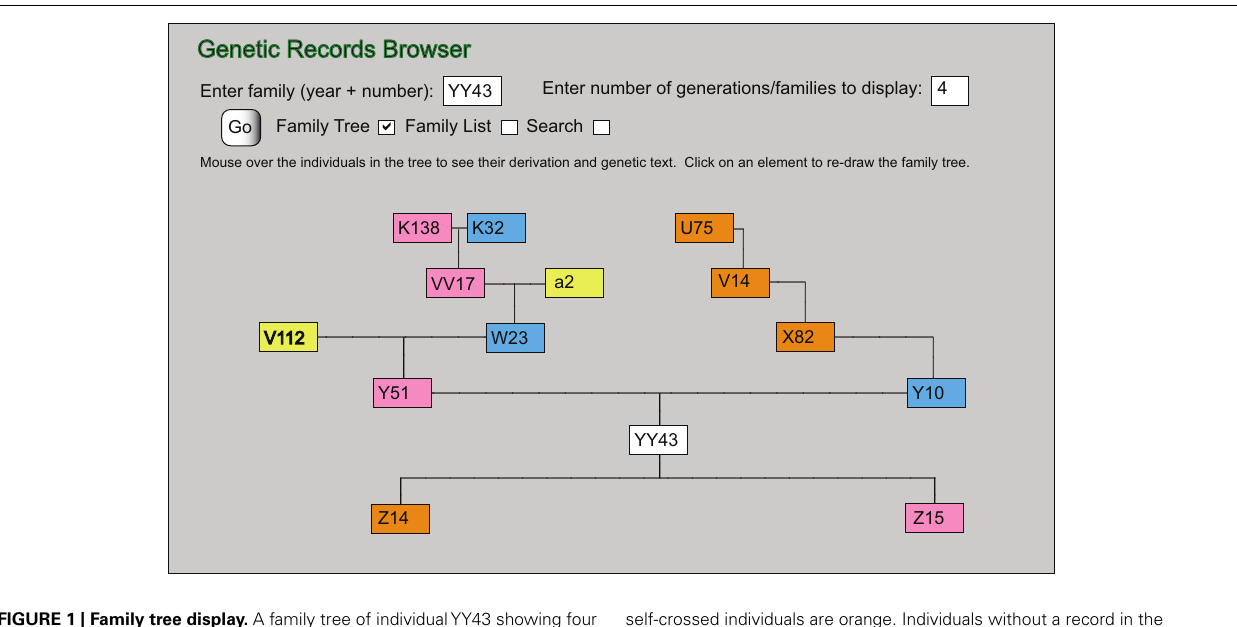
FIGURE 1 | Family tree display. A family tree of individualYY43 showing four parental generations and one child generation of two offspring. Each box represents an individual used in or resulting from a cross. Individuals used as a maternal parent are colored pink, paternal parents are colored blue, and